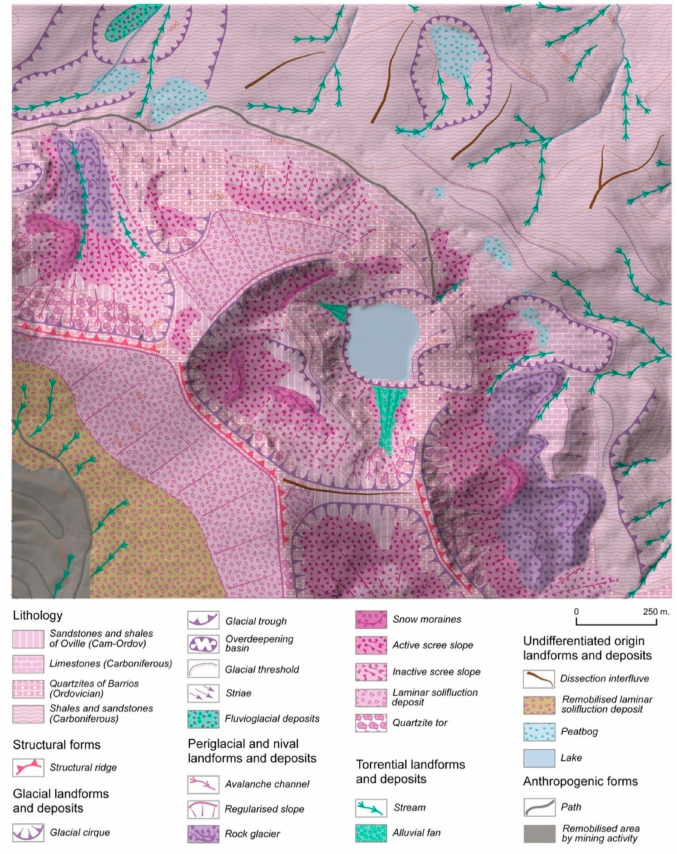
Figure 3. Geomorphological map of Ausente Peak. Composed by the authors using IGN MDT05 and Base topogr á fica